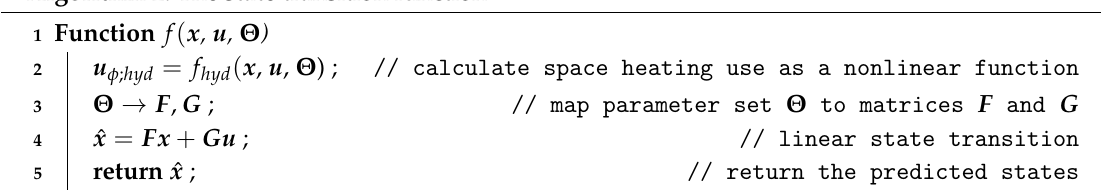
Algorithm 2: The state transition